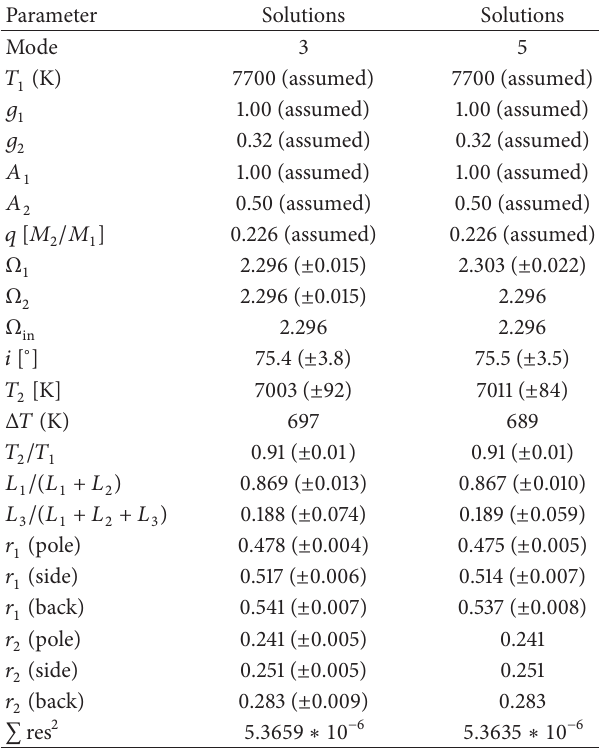
two data points. The large group of minima are between 𝐸 = 4800